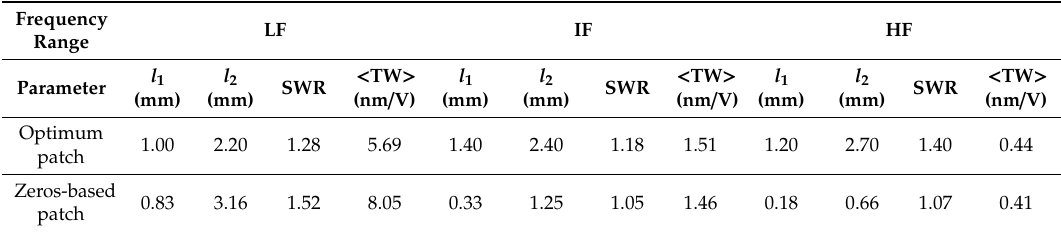
Table 3. Figures of merit deduced from the TW envelopes of Figure 4 for the two types of patches under study for the three frequencies considered. The values for the design parameters l 1 and l 2 are also